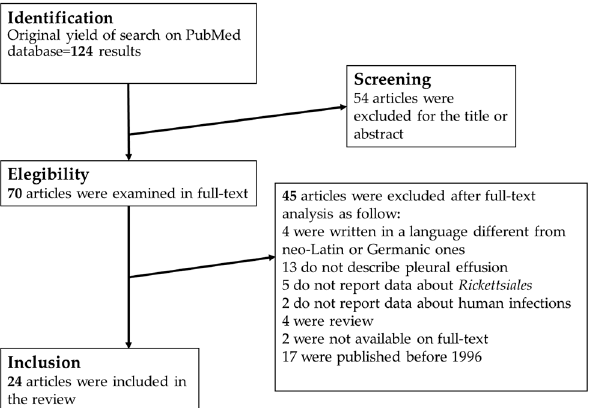
Figure 2. Process of bibliographic research for review about pleural effusion in course of Rickettsiales infection in the world .